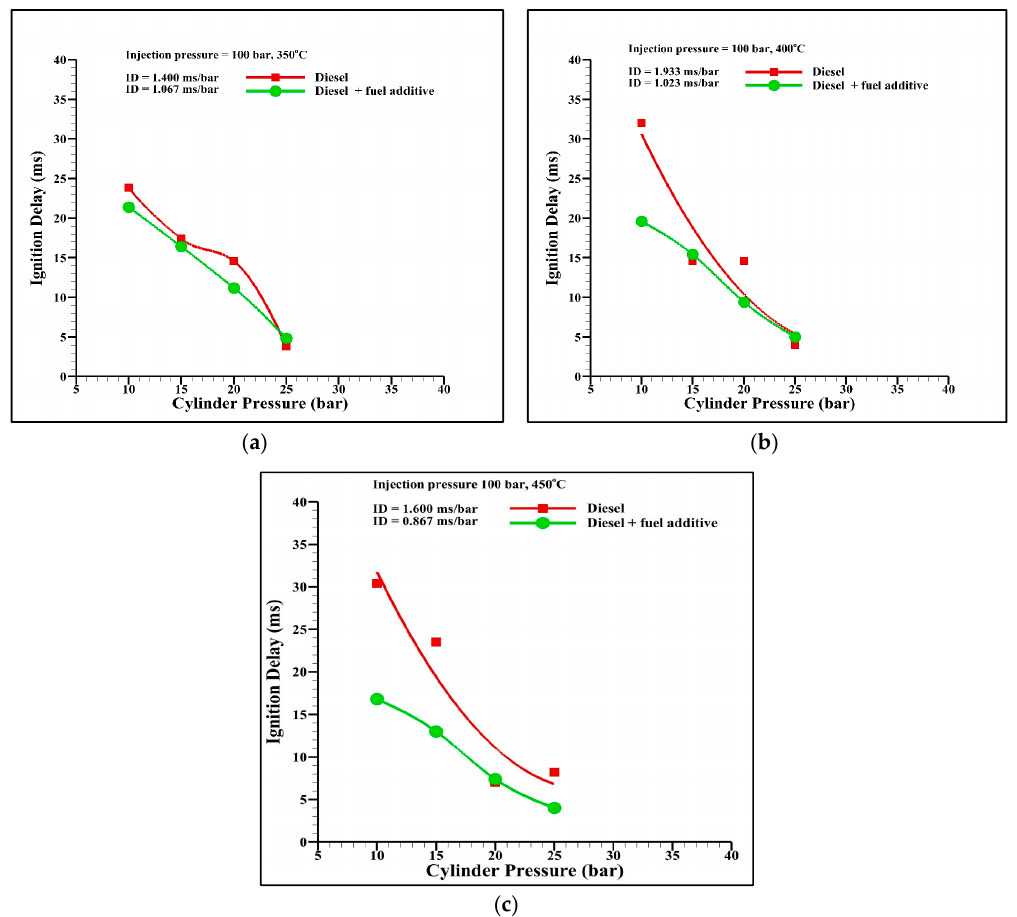
Figure 4. Ignition delay (ID) deviation of diesel and diesel with fuel additive at injection pressure 100 bar. ( a ) CAP 10-25, HST 350; ( b ) CAP 10-25, HST 400; ( c ) CAP 10-25, HST 450.